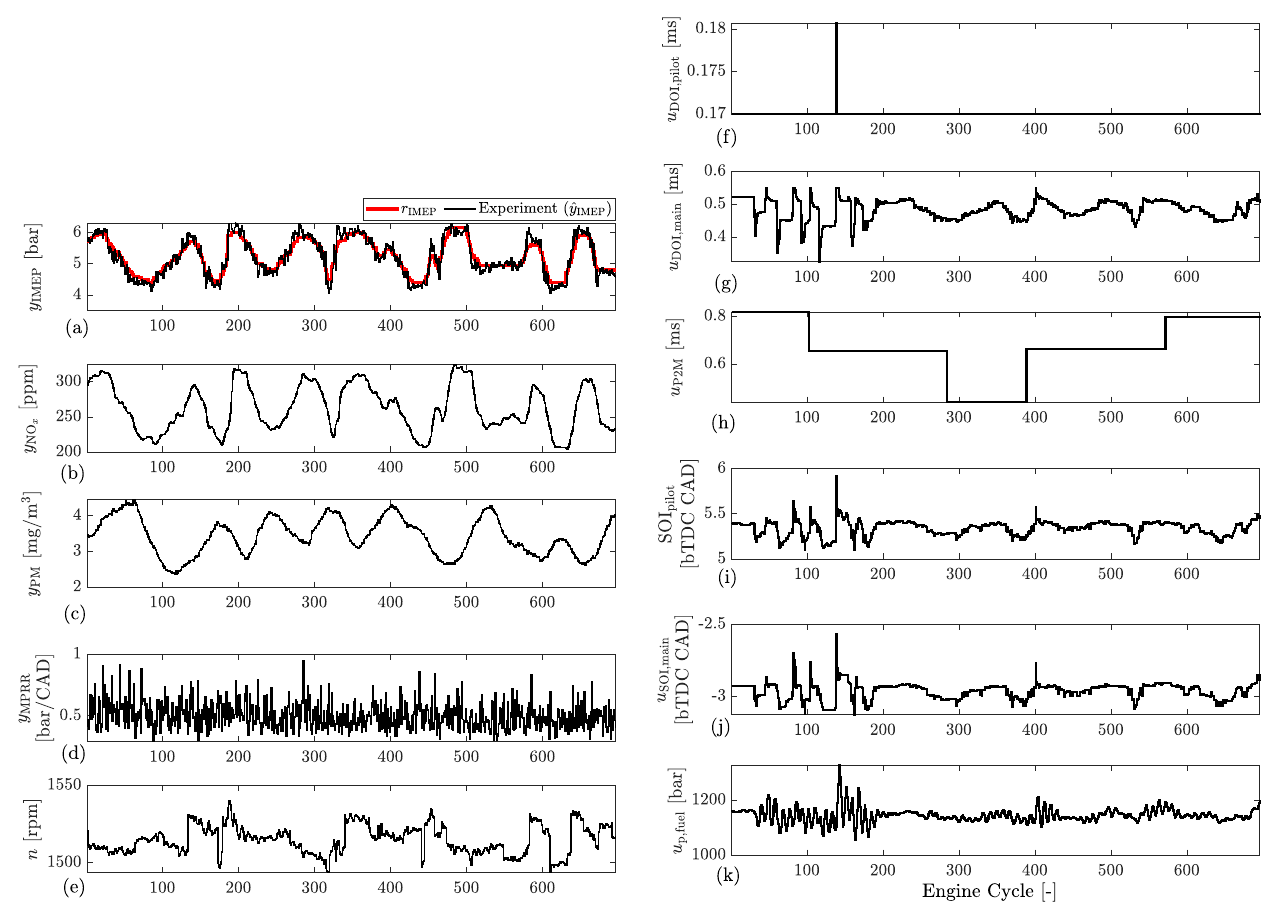
Figure 11. Experimental results at n = 1500 rpm: smooth IMEP setpoint with a bandwidth of approx- imately 1 Hz—( a ) indicated mean effective pressure (IMEP), ( b ) nitrogen oxide (NO x ), ( c ) Particle Matter (PM), ( d ) maximum pressure rise rate (MPRR), ( e ) engine speed, ( f ) duration of injection (DOI) of pilot injection, ( g ) DOI of main injection, ( h ) duration between end of pilot injection and start of main injection, ( i ) start of injection (SOI) of pilot injection, ( j ) SOI of main injection, ( k ) fuel rail